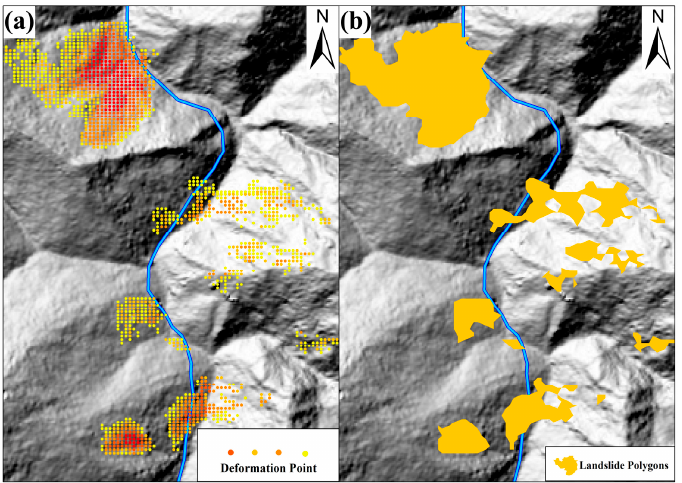
Figure 3. Schematic diagram of point aggregation. ( a ) Deformation points extracted by hotspot analysis. ( b ) Landslide polygons generated by point aggregation.